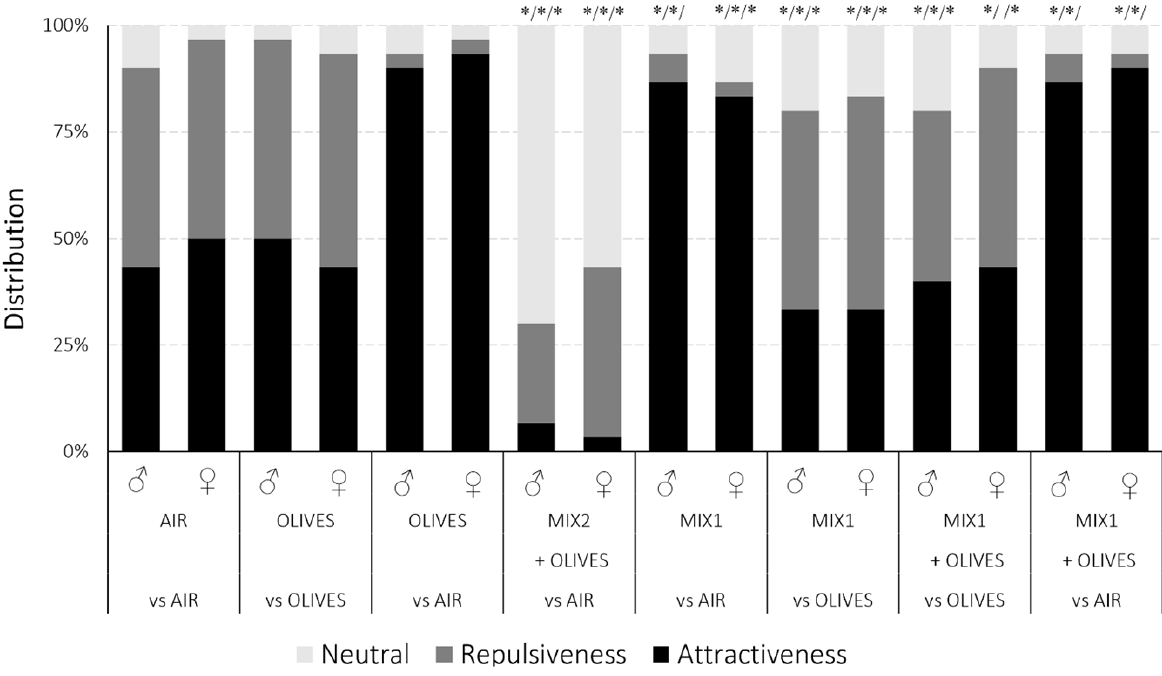
Figure 3. Distribution (%) of the responses among attractiveness (black), repulsiveness (grey) and neutral (light grey) of the male ( ♂ ) and female ( ♀ ) adult OLF in olfactometry tests with different SWs at 10% concentration. AIR vs AIR = Control with both the lateral chambers left empty; OLIVES vs OLIVES = Control with 12 olives (attractiveness) in each lateral chamber. AIR vs OLIVES = Control with 12 olives, attractiveness, in contraposition with clean air; MIX2 + OLIVES vs AIR = 150 µL of Mixture in equal parts of the SWs obtained from cellulose, wood, corn and alfalfa at both 300 and 500 °C offered in combination with 12 olives (attractiveness) and in contraposition to clean air; MIX1 vs AIR = Mixture in equal parts of the SWs obtained from olive mill waste at both 300 and 500 °C offered in contraposition to clean air; MIX1 vs OLIVES = Mixture in equal parts of the SWs obtained from olive mill waste at both 300 and 500 °C offered in contraposition to 12 olives (attractiveness);